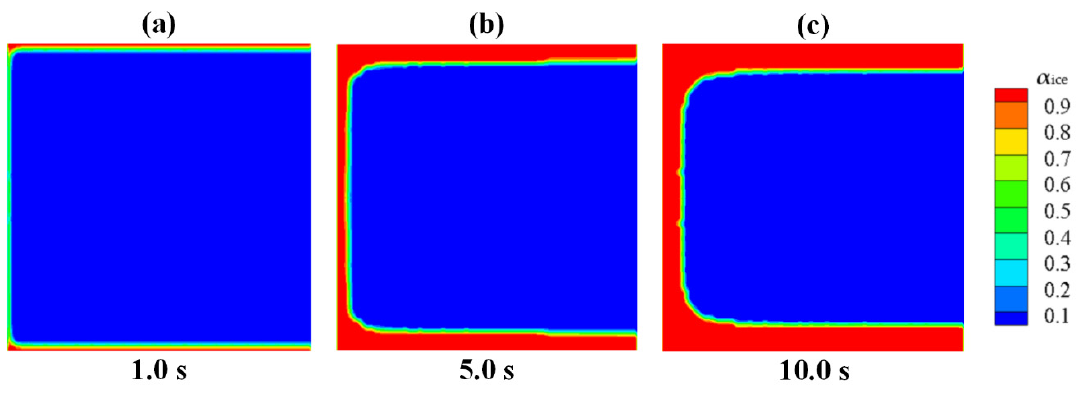
Figure 7. Contours of ice phase fraction at various moments for case 1 ( a ) 1.0 s, ( b ) 5.0 s, and ( c ) 10.0 s.